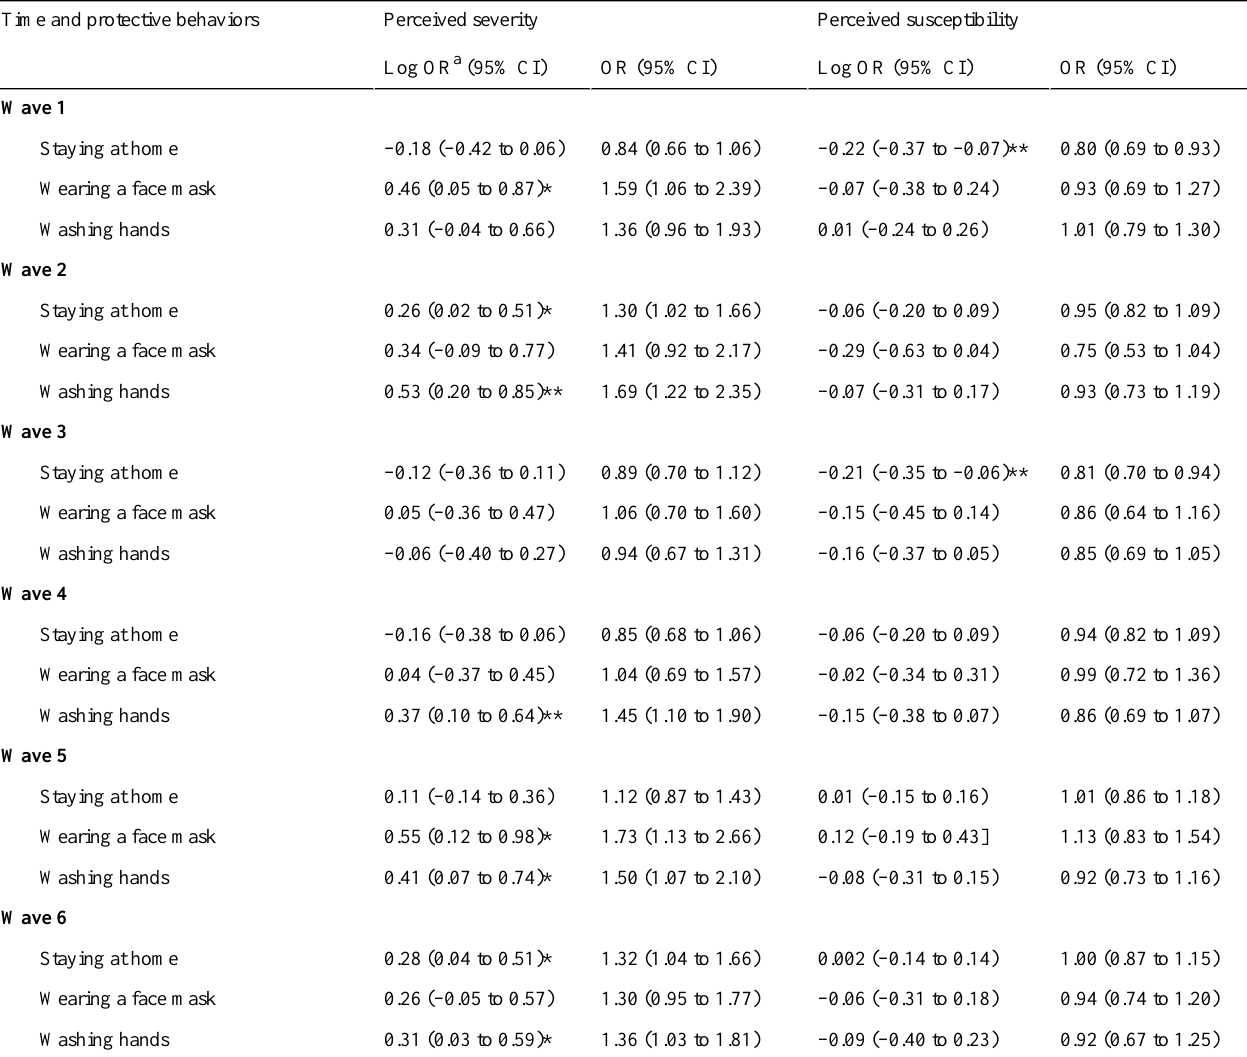
Table 4. The effects of perceived severity and perceived susceptibility on engagement in protective behaviors across time.